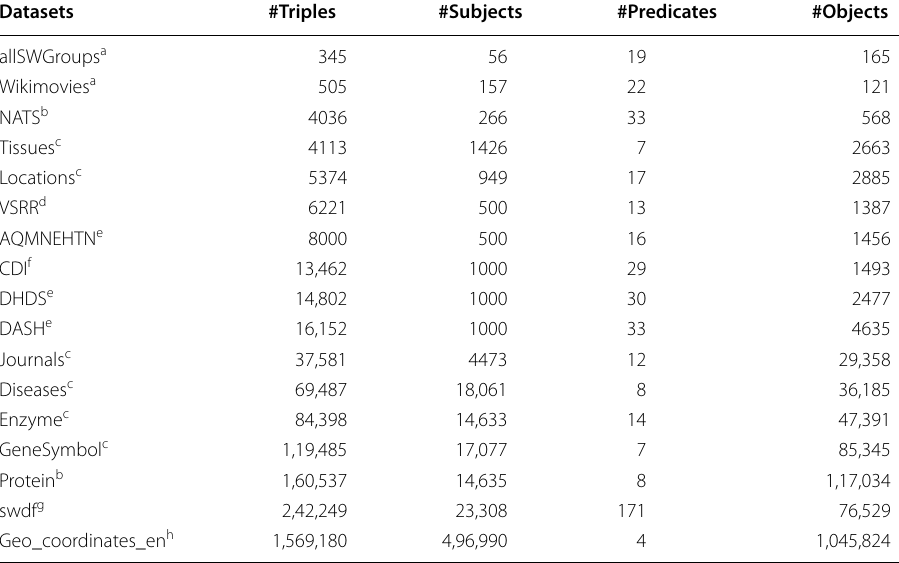
Table 1 The basic statistics of